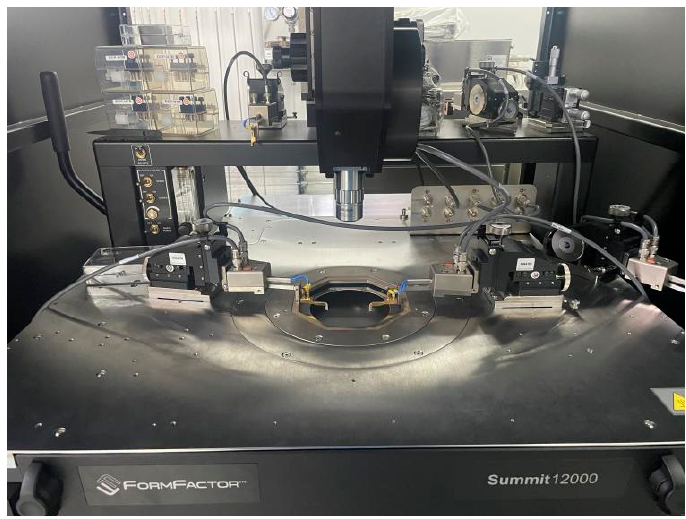
Figure 5. Experimental platform construction result.